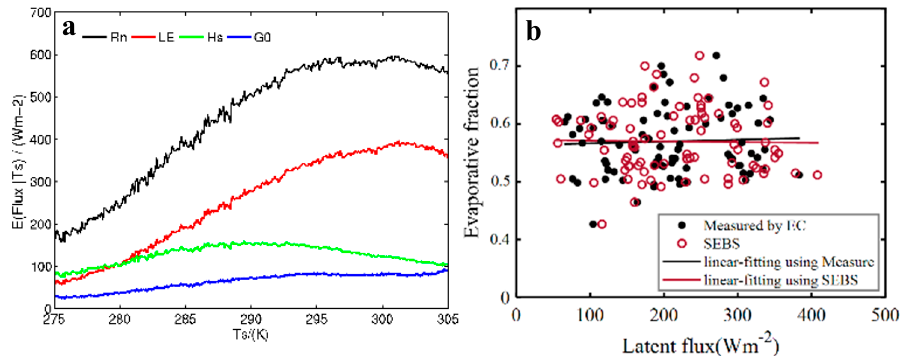
Figure 6. ( a ) Trend of energy fluxes conditional expectation with the land surface temperature. ( b ) Relationship between evaporation fraction (EF) and latent heat flux.